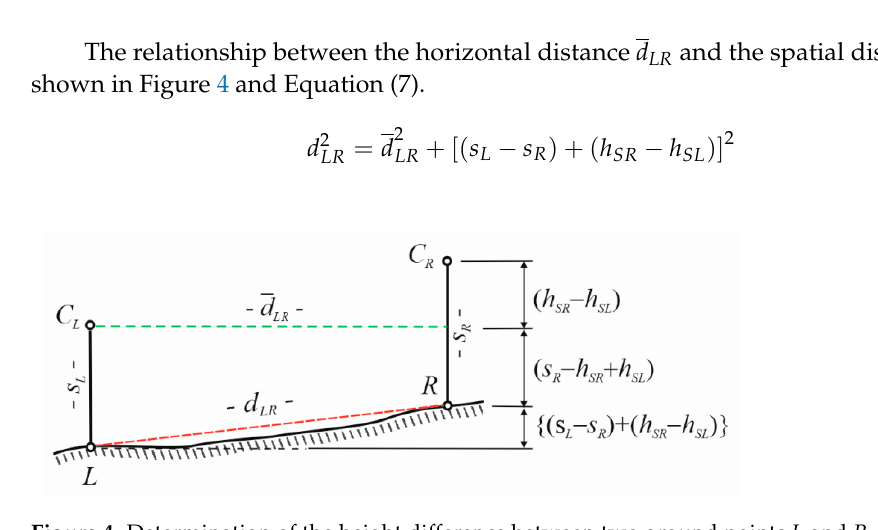
Figure 4. Determination of the height difference between two ground points L and R. Substitution of Equation (6) to Equation (7) and employment of the general Equation for height difference (4) yields an equation for distance d LR as a function of results of a classical field survey (horizontal distances d SL , d SR ; horizontal angle β LSR ; vertical angles α SL , α SR and signal heights s L , s R ):